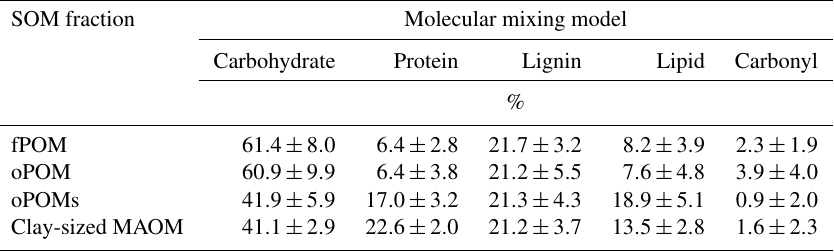
Table 3. Results from the molecular mixing model with data obtained by 13 C CP-MAS NMR spectroscopy and calculated according to the molecular mixing model by Baldock et al. (2004) and Nelson and Baldock (2005): five-component model (without char) with N/C constraint. Given are mean values and the standard deviation of free (fPOM), occluded (oPOM) and small occluded (oPOMs) particulate organic matter and of clay-sized mineral-associated organic matter